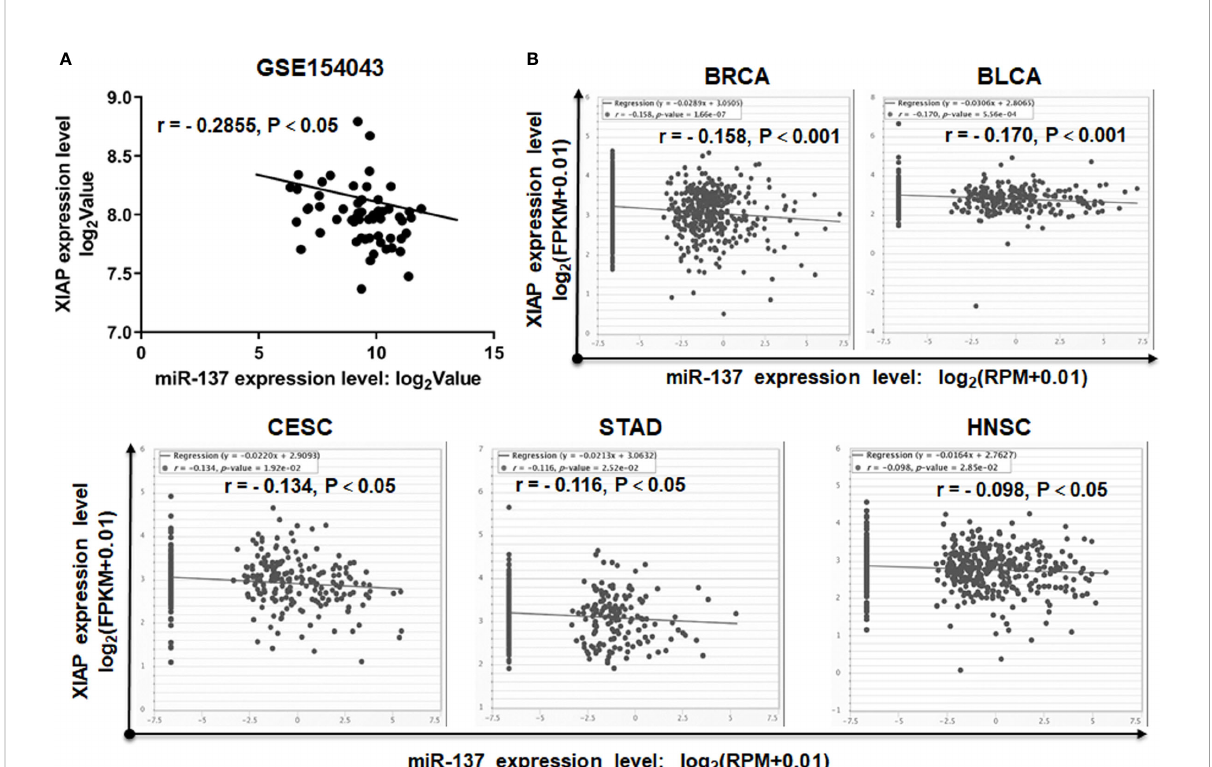
FIGURE 5 miR-137 negatively correlates with XIAP mRNA levels in cancer patient samples. (A) The correlation between miR-137 and XIAP expression in glioblastoma cohorts (GSE154043). [The p value was determined by Pearson correlation test]. (B) TCGA Correlation analysis of miR-137 and XIAP in TCGA database (BRCA, BLCA, CESC, STAD and HNSC). The relative levels of miR-137 were plotted against that of XIAP using the online tool